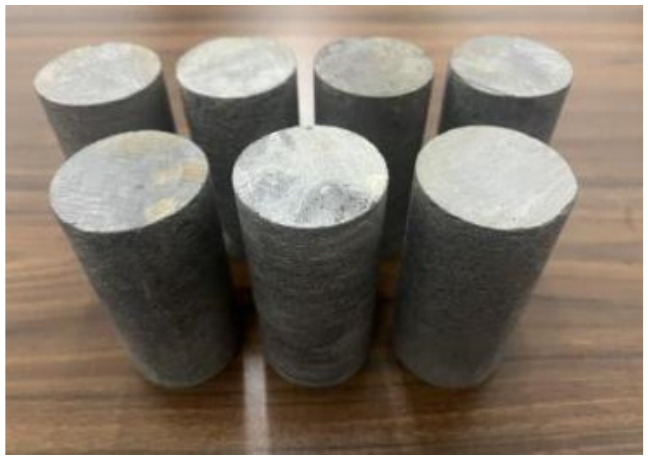
Figure 2. Part of mudstone test piece.